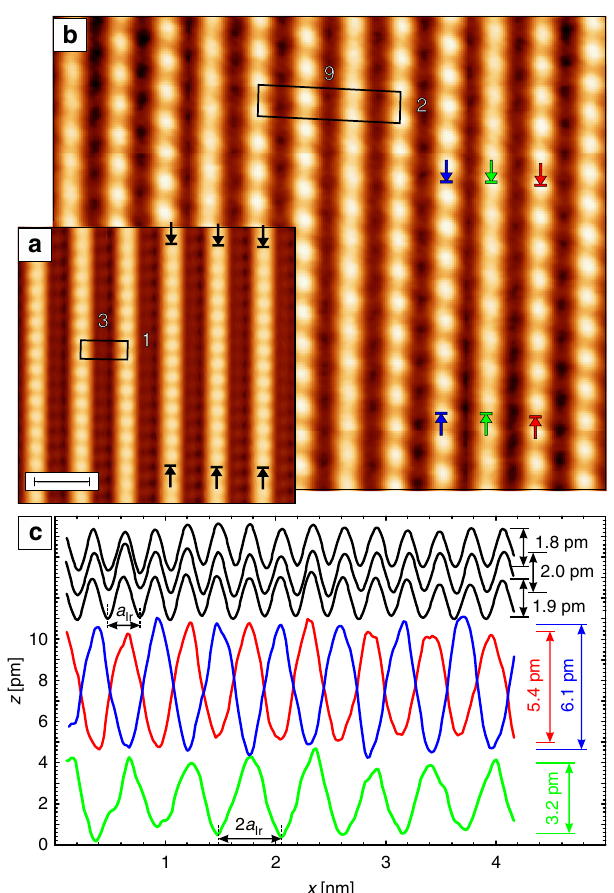
Fig. 2 Atomic resolution scans of MnO 2 chains on Ir(001). a A (3 × 1) structural unit cell is observed with a non-magnetic W tip (scale bar: 1 nm). b With a Cr-coated W tip the magnetic (9 × 2) unit cell is resolved. c Line pro fi les drawn along the stripes at the positions indicated by arrows measured with the W (black) and the Cr-coated (colored) probe tip. Spin- resolved line sections differ in periodicity, phase, and amplitude from their spin-averaged counterparts (see main text for details). Scan